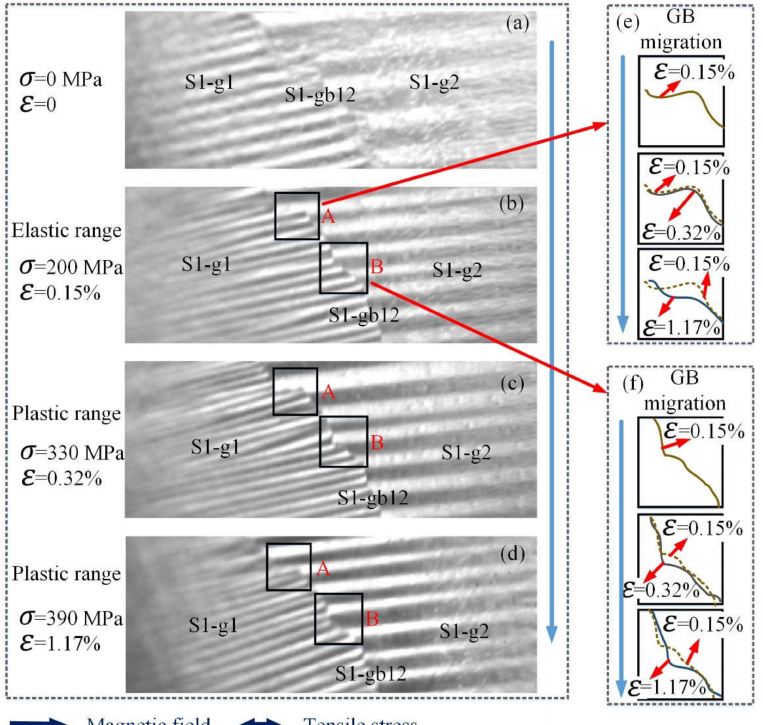
Figure 5. The variation of DW distribution and GB migration under stress of silicon steel sheet sample 1. ( a – d ) show the DW distribution and GB evolution under stress in elastic and plastic range; ( e , f ) show the schematic representation of GB migration under stress in elastic and plastic range. The sizes of ( a – d ) are 4.2 mm × 12.6 mm. The size of region A is 1.2 mm × 1.3 mm. The size of region B is 1.4 mm × 1.5